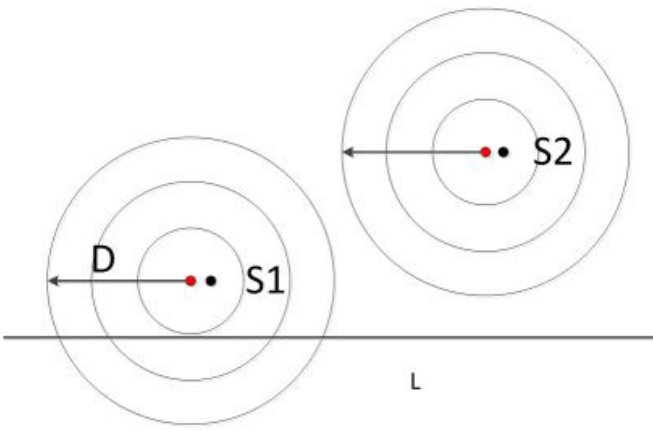
Figure 11. Edge node